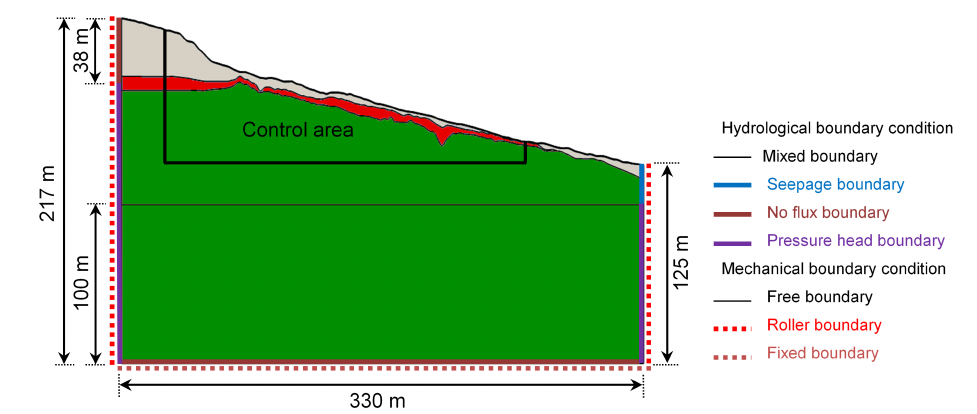
Figure 8. The 2D cross-section used for hydromechanical modeling including boundary conditions for the hydrological and mechanical model